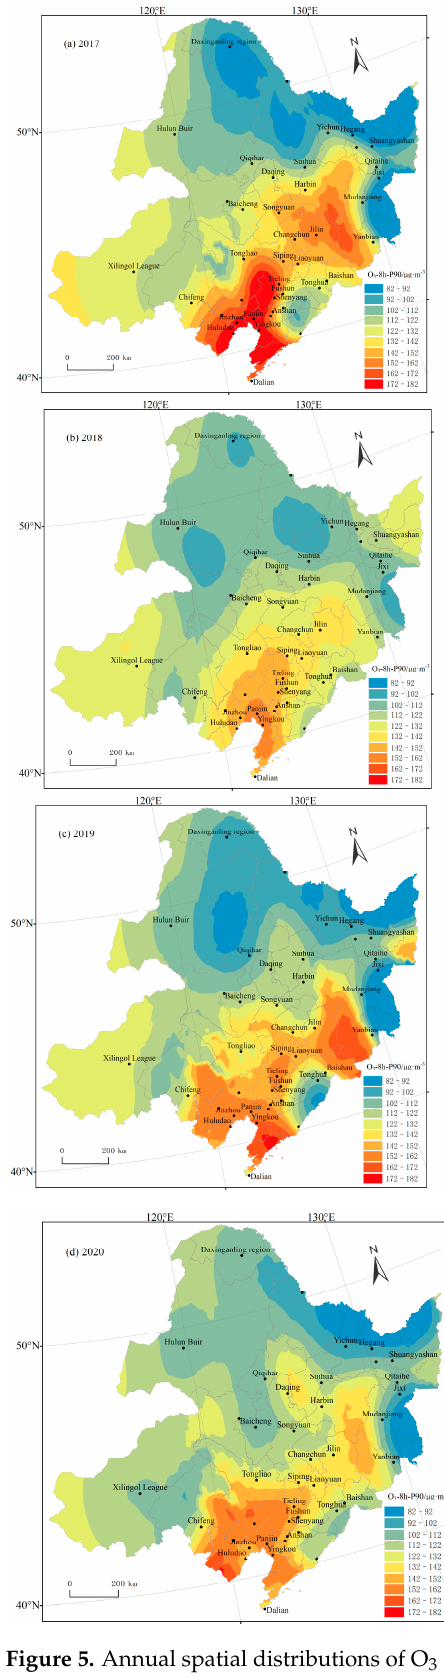
Figure 5. Annual spatial distributions of O 3 concentrations from 2017 to 2020 in Northeast China.